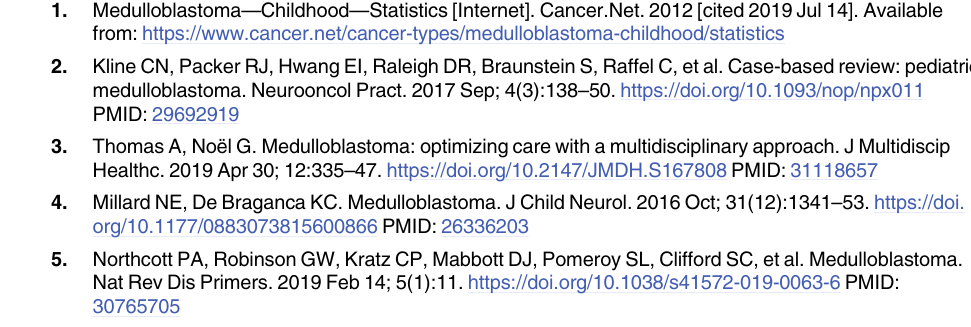
S3 Table. Subtype classification with p-value significance (t-test) of each sample across 15 test MB